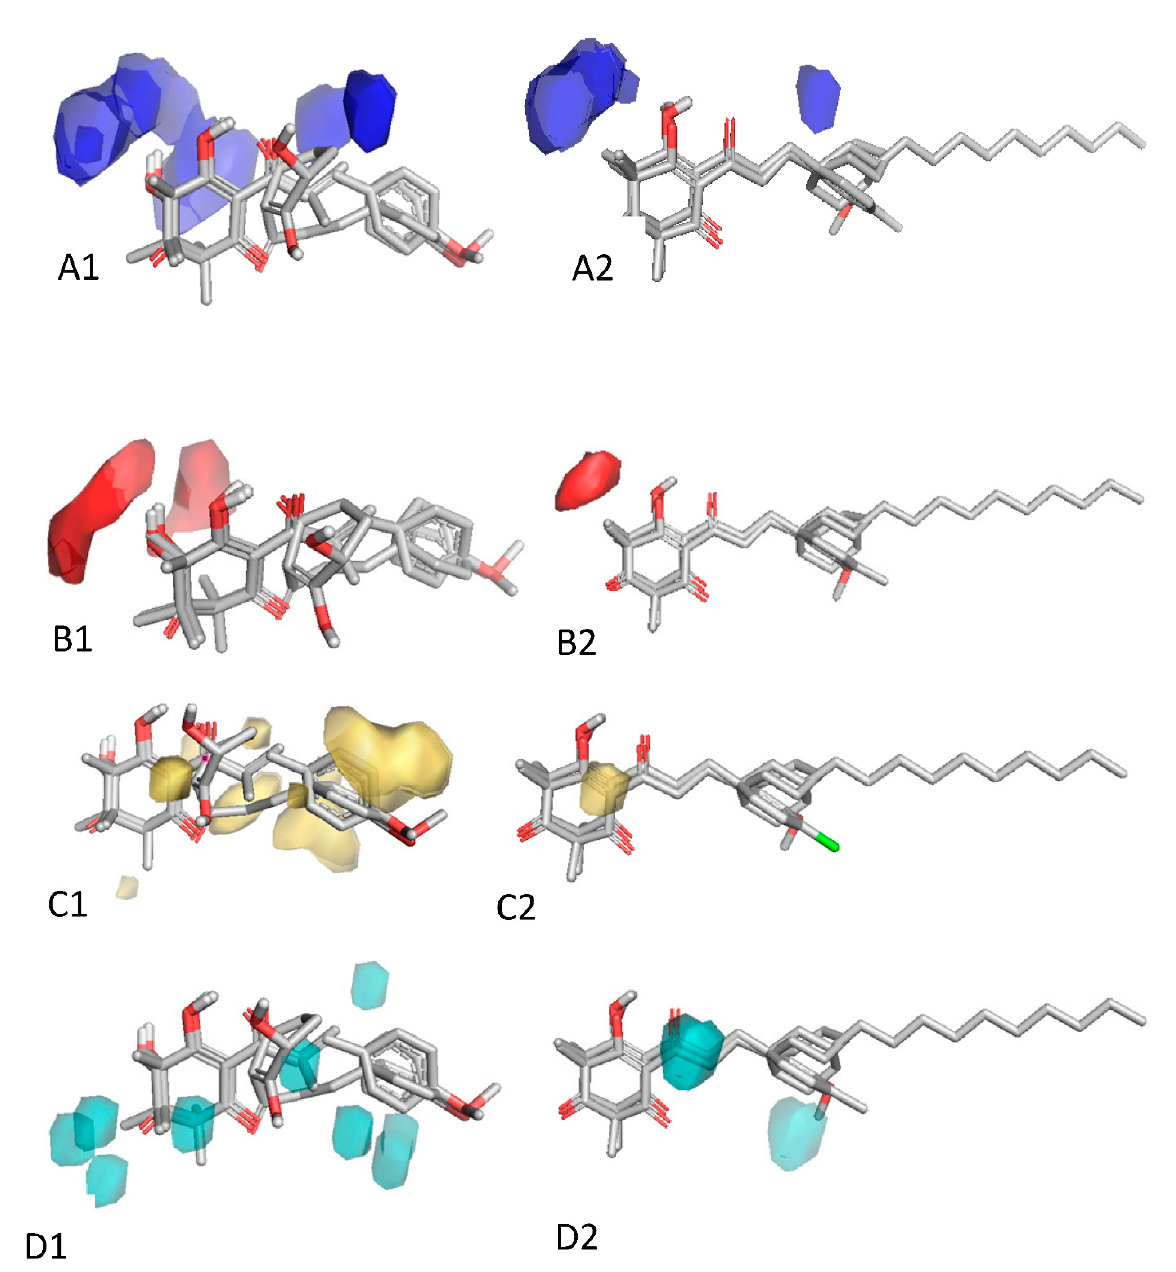
Figure 4. Structural features contributing negatively to the activity of 2-acyl-cyclohexane-1,3-diones on HPPD. ( A1 , A2 ) Blue fields highlight regions where the presence of hydrogen donors reduce activity. ( B1 , B2 ) Red fields highlight hydrogen acceptor regions that negatively affect activity. ( C1 , C2 ) Yellow fields identify hydrophobic regions near to the triketone ring that negatively affect activity. ( D1 , D2 ) Cyan fields delineate regions where steric interactions reduce activity.